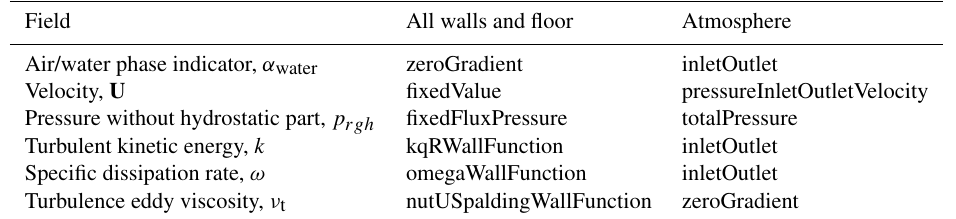
Table 1. OpenFOAM boundary conditions for the current numerical model (for the fixedValue boundary condition, a constant value of 0 is used for the model in this